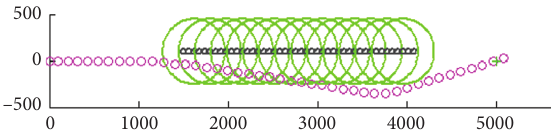
Figure 6: Simulation of uniform single speed obstacle collision